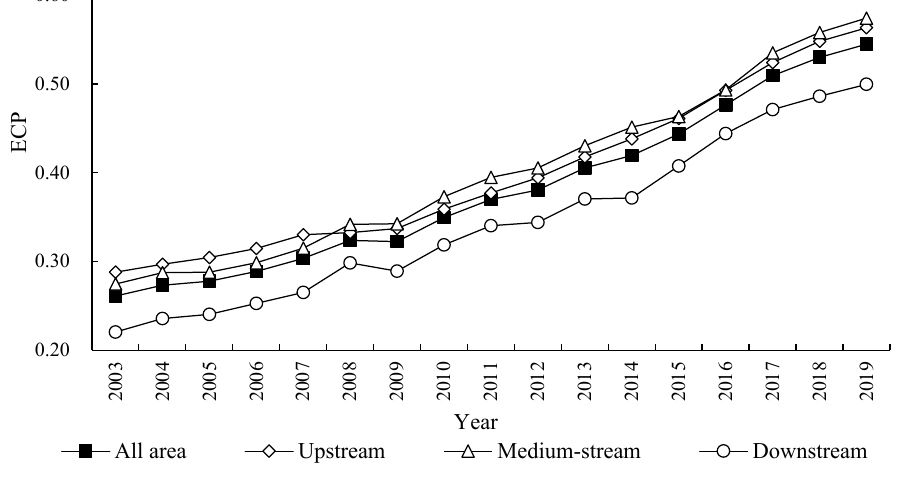
Figure 3. Evolution trend of ECP in the YRB from 2003 to 2019.